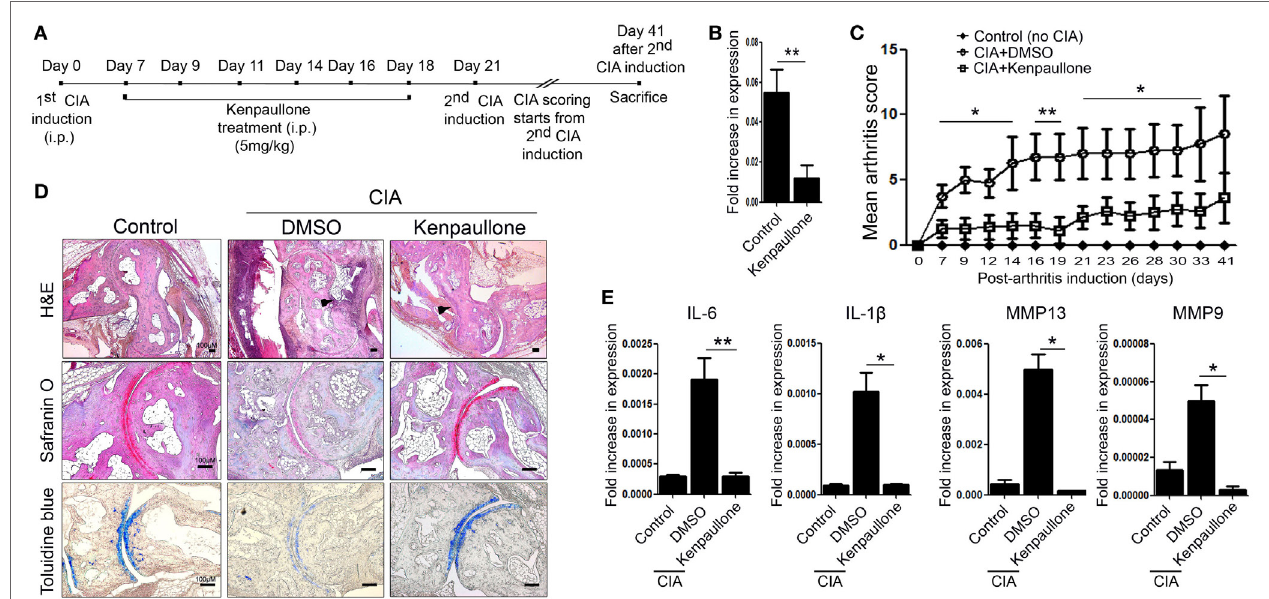
FigUre 4 | Inhibition of Kruppel-like factor (KLF) 4 with Kenpaullone reduces autoimmune arthritis in the collagen-induced arthritis (CIA) mouse model. (a) Experimental induction of CIA and Kenpaullone treatment. (b) Expression of KLF4 mRNA by control and Kenpaullone-treated murine fibroblast-like synoviocytes. (c) Mean arthritis score for control mice (no collagen induction) ( n = 3), CIA mice treated with 10% dimethyl sulfoxide (DMSO) ( n = 4), and CIA mice treated with Kenpaullone ( n = 8). (D) Immunohistochemical staining of the hindlimb. Staining was performed as described in Figure 2e . Cellular infiltration is pointed by arrow heads. Data are representative of at least five replicates of the staining per each group. Original magnification: hematoxylin and eosin (H&E), 50 × ; Safranin O and Toluidine blue, 100 × . (e) Expression of mRNA encoding interleukin (IL)-6, IL-1 β , matrix metallopeptidase 13 (MMP13), or MMP9 in paw cells. Values in panels (b,c,e) are expressed as the mean ± SEM (* P < 0.05 and ** P <